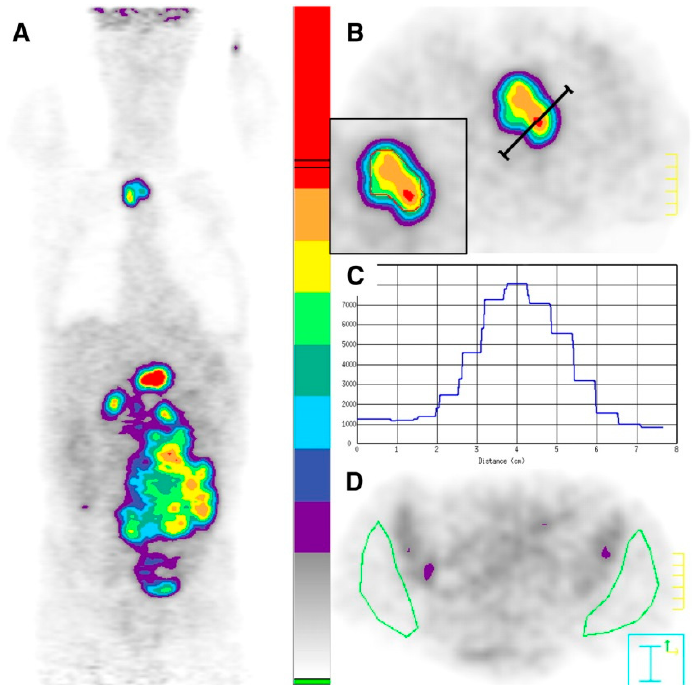
Figure 3. Selection of regions of interest in 57-y-old patient before chemotherapy. ( A ) Graded color-scaled parametric analysis applied in reconstructed coronal PET image shows most active tumor in upper abdomen. ( B ) Transverse PET image with a higher scale reveals celiac tumor (T) with activity profile crossing the hottest point (red spot). ( C ) Corresponding activity profile in counts-per-pixel. Isocontours are drawn with lower autocontour threshold of 4500 counts-per-pixel (red isocontour at inset in B). ( D ) Normal background tissue (N): two large ROIs are manually selected on gluteal muscles, avoiding iliac bone marrow activity. This research was originally published in JNM [76]. © SNMMI.